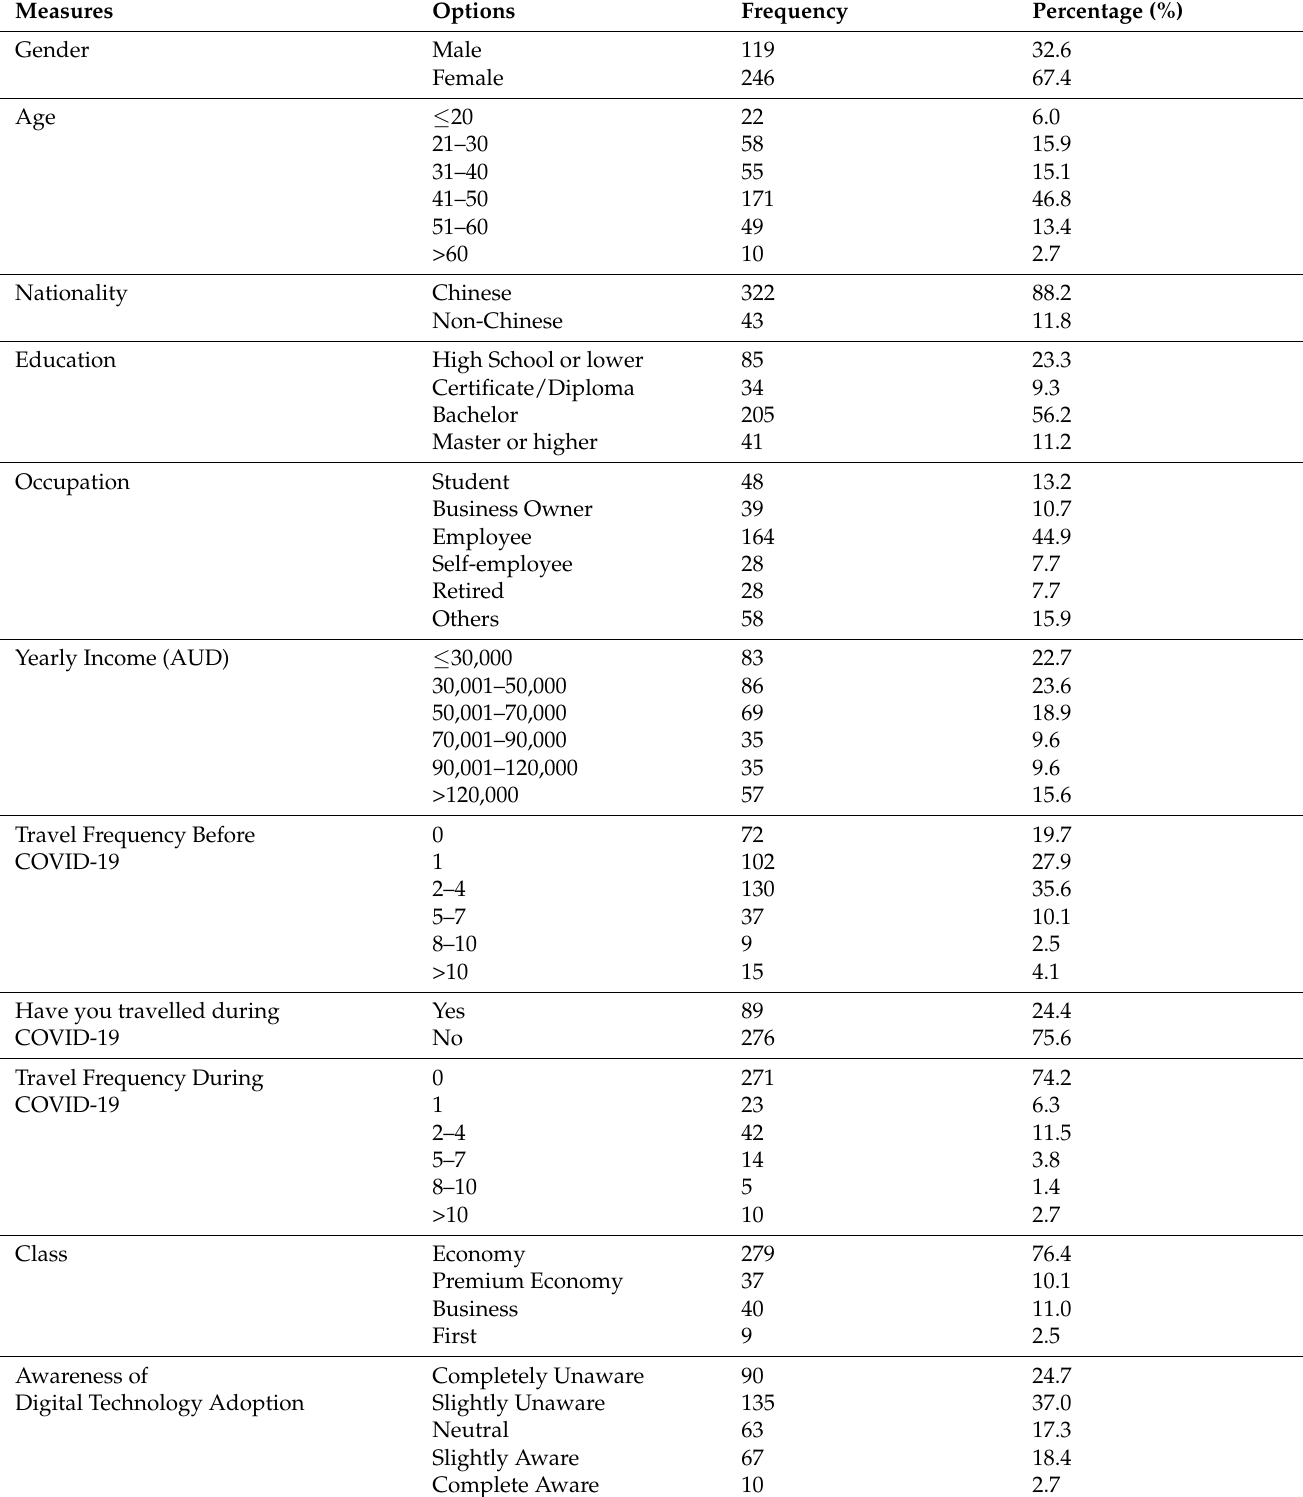
Table 1. Demographic information (N =